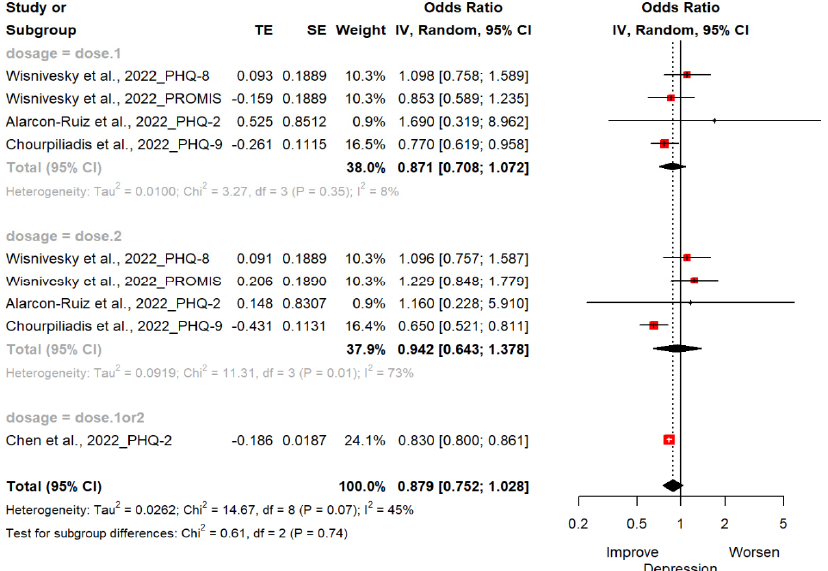
Figure 2. Forest plot diagram showing the effect of COVID-19 vaccination on depression. Odds ratio; CI, confidence interval [18–21].